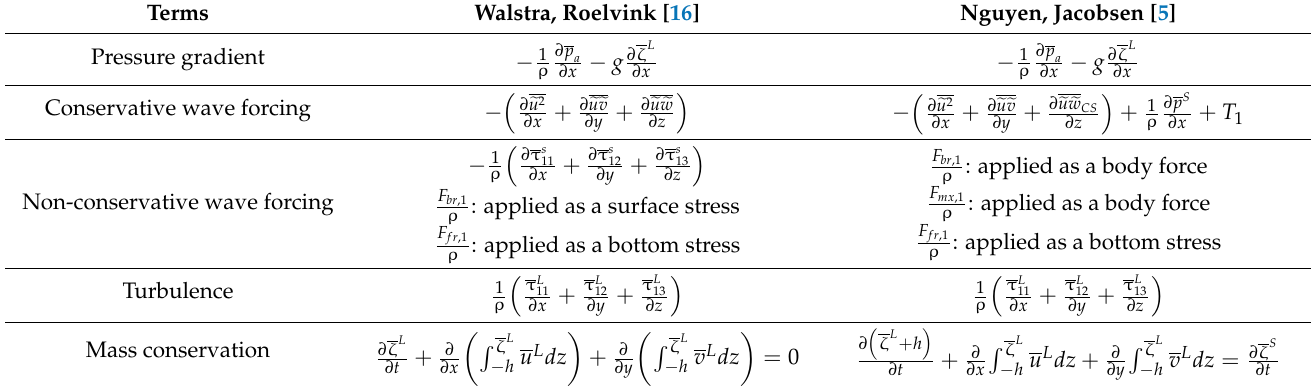
F br ,1 ρ : applied as a body force F mx ,1 ρ : applied as a body force F fr ,1 ρ : applied as a bottom stress